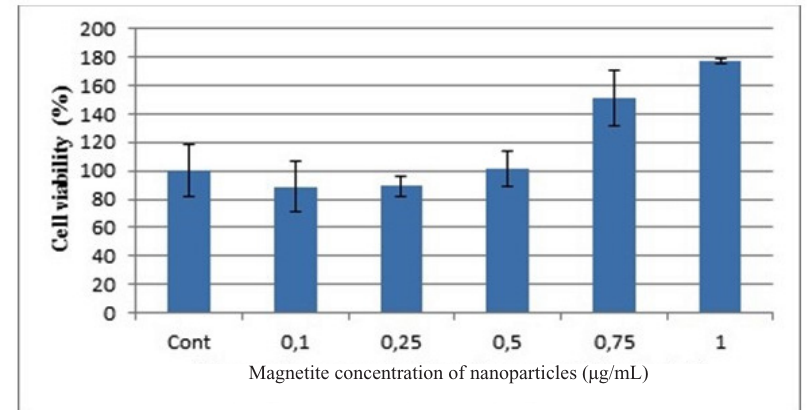
O nanoparticles. 3 4